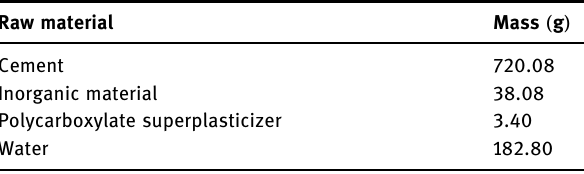
Table 2: The ratio of inorganic binders Raw